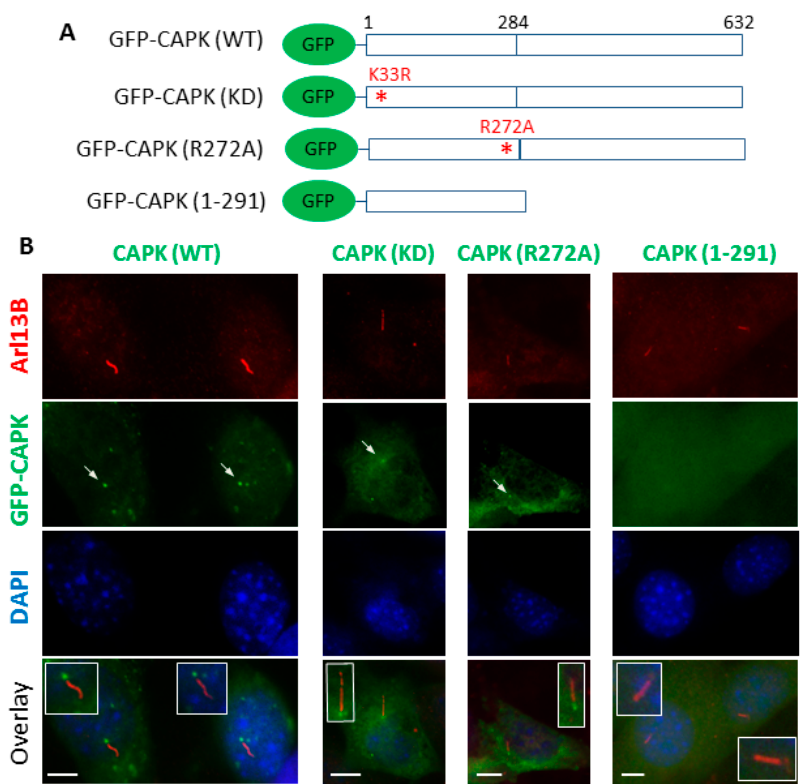
Figure 4. The C-terminal domain (CTD) of CAPK is required for ciliary targeting. ( A ) Schematic diagrams of GFP-CAPK wild type (WT), kinase dead (KD), loss-of-function mutation R272A, or CTD-truncation (1–291) constructs transiently transfected into NIH-3T3 cells. ( B ) NIH-3T3 cells were stained with cilia marker Arl13B antibody followed by Alexa Fluor 594-conjugated secondary antibody (red). Nuclei were stained with DAPI (blue) in the mounting medium. Scale bars, 5 µm.